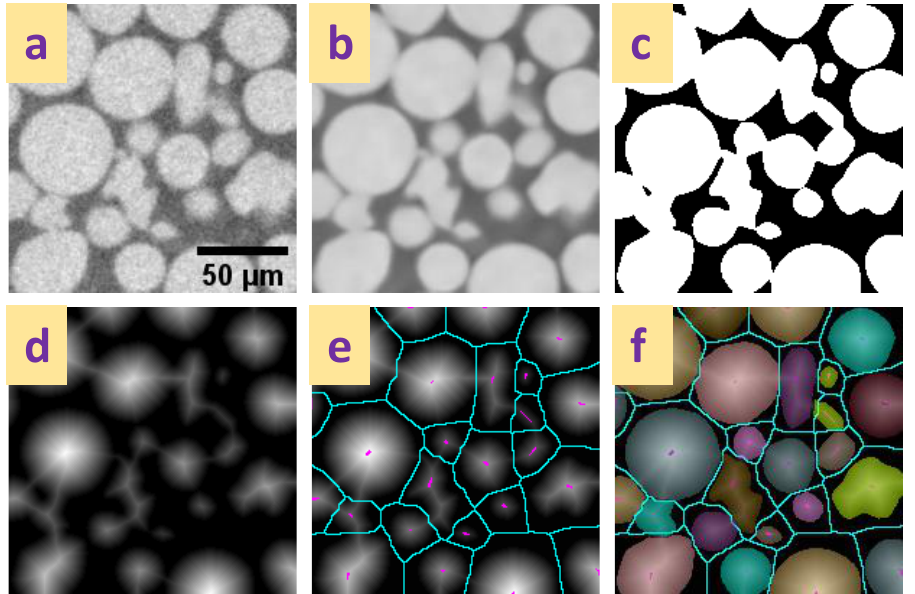
Figure 6. Particle separation process with a distance-transform watershed method. ( a ) Unprocessed image, ( b ) smoothed image (non-local means filter), and ( c ) binarised image, ( d ) distance-transform of the binary image shown in Figure 6c, ( e ) distance transform with the extended maxima markers (purple) and watershed lines (blue) shown, ( f ) segmented particles resulting from re-flooding the image from the markers to the boundaries of the binary mask image and the watershed lines.